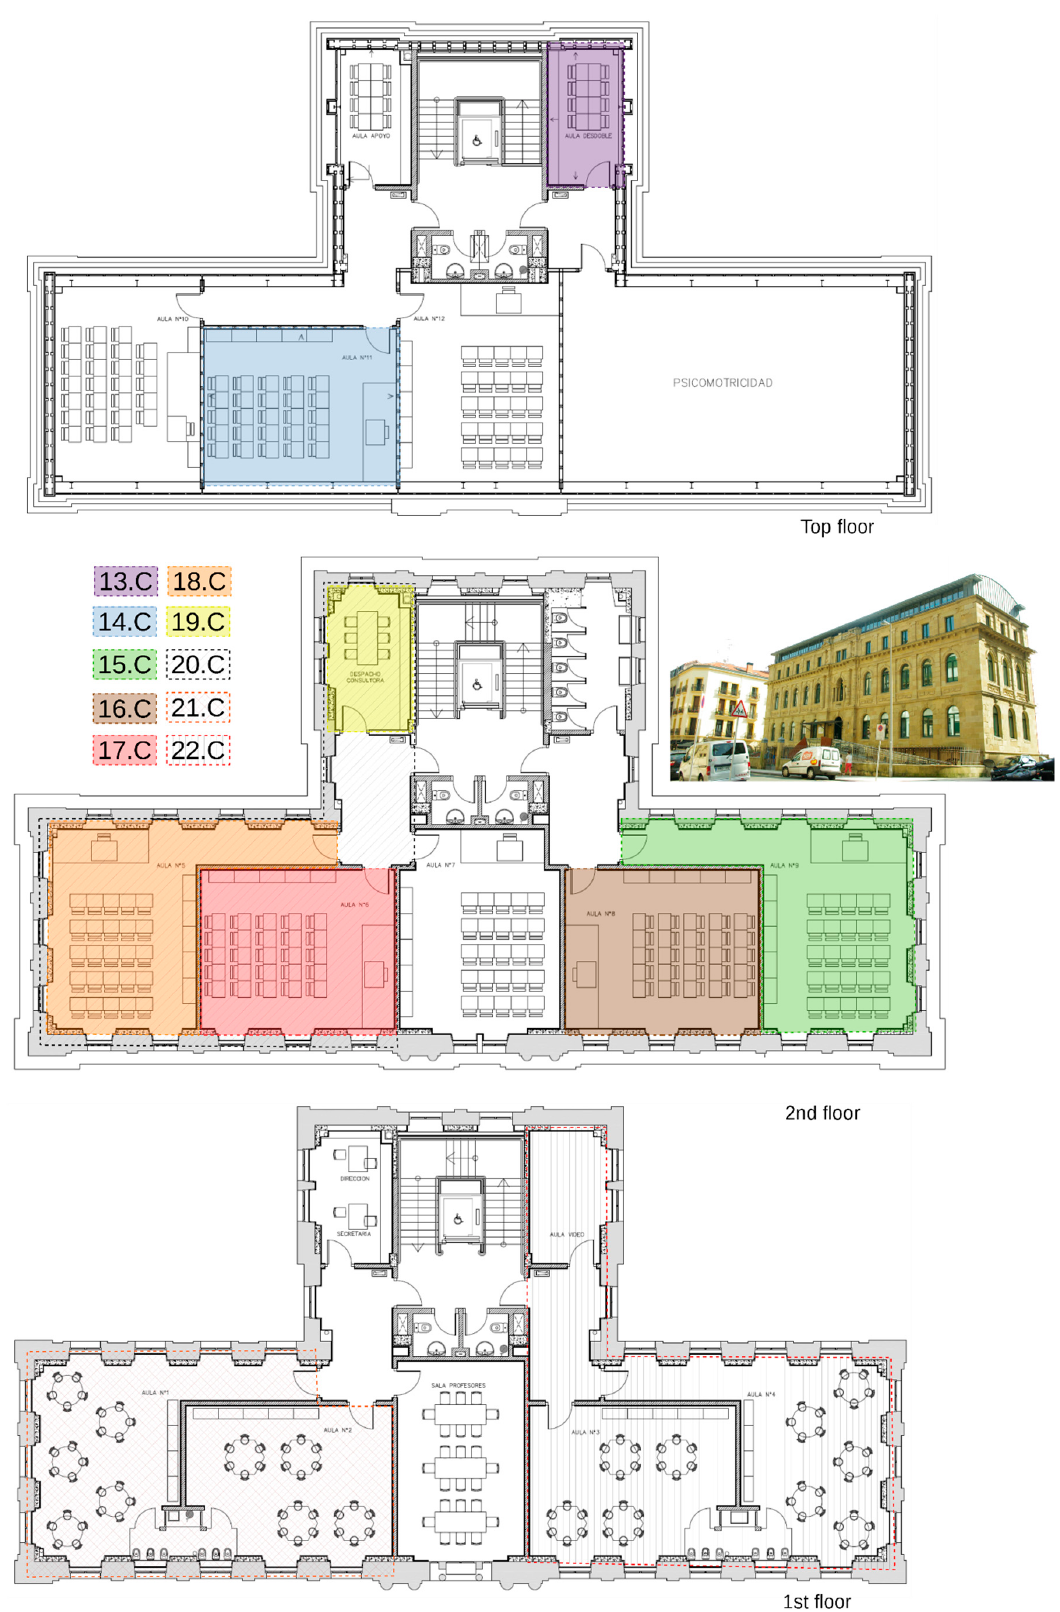
Figure A3. Floor plans of the blower door tests performed in the Aldamar School case study.